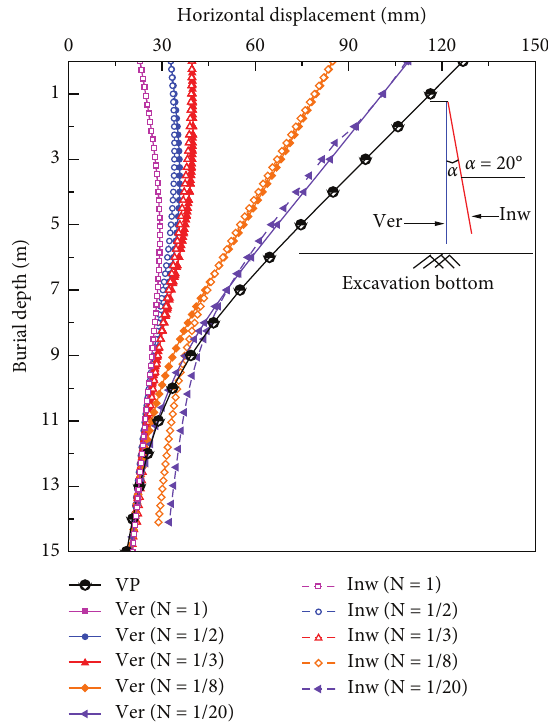
Figure 19: Comparison of horizontal displacements of VIIP with different N